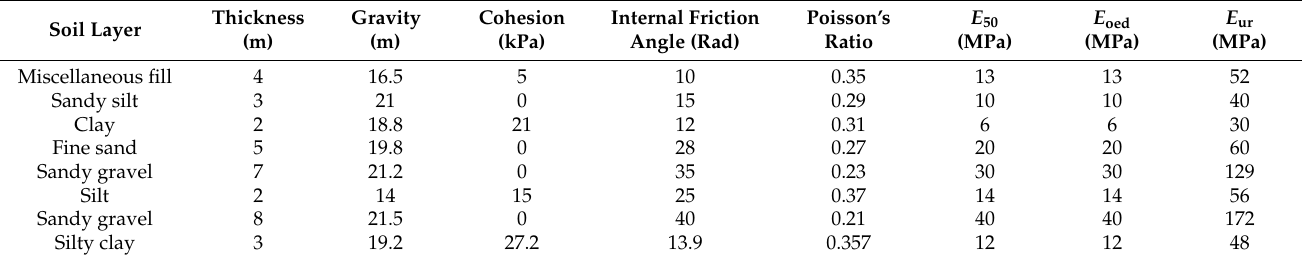
Table 3. Physical and mechanical parameters of different soil layers.